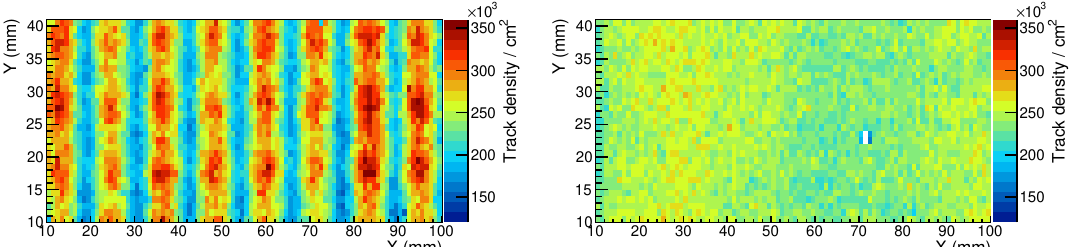
Figure 12 . Track density distribution observed in the emulsion detector. Left: the target mover driven with a constant speed during beam on (2016). The periodical pattern corresponds to the scanning step in X. Right: the same plot with an intensity driven control